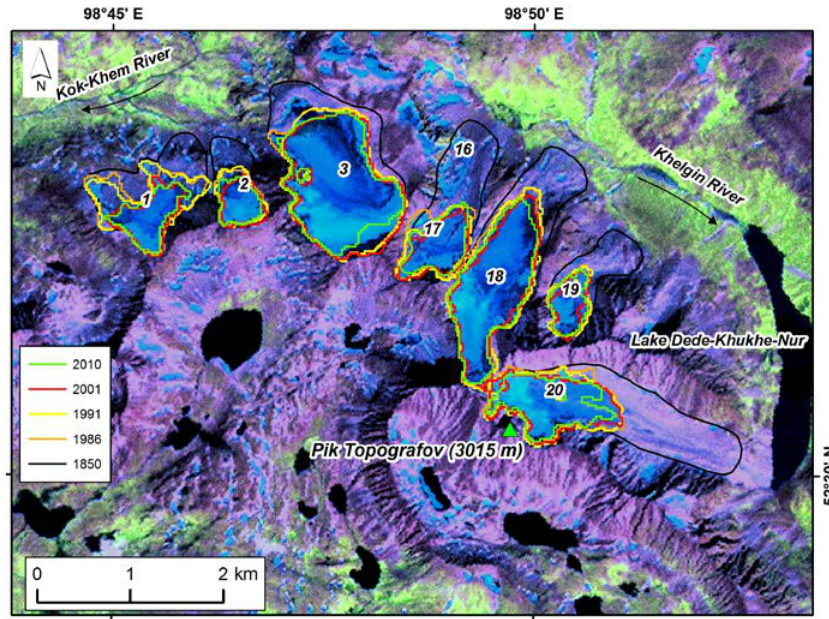
Figure 4. Glacier extents between 1850 (end of the Little Ice Age) and 2010 in the region of Pik Topografov (the green triangle is in the lower center). The background is a false color composite from Landsat ETM+ (9 August 2001) with bands 5, 4 and 3 (as red, green and blue).